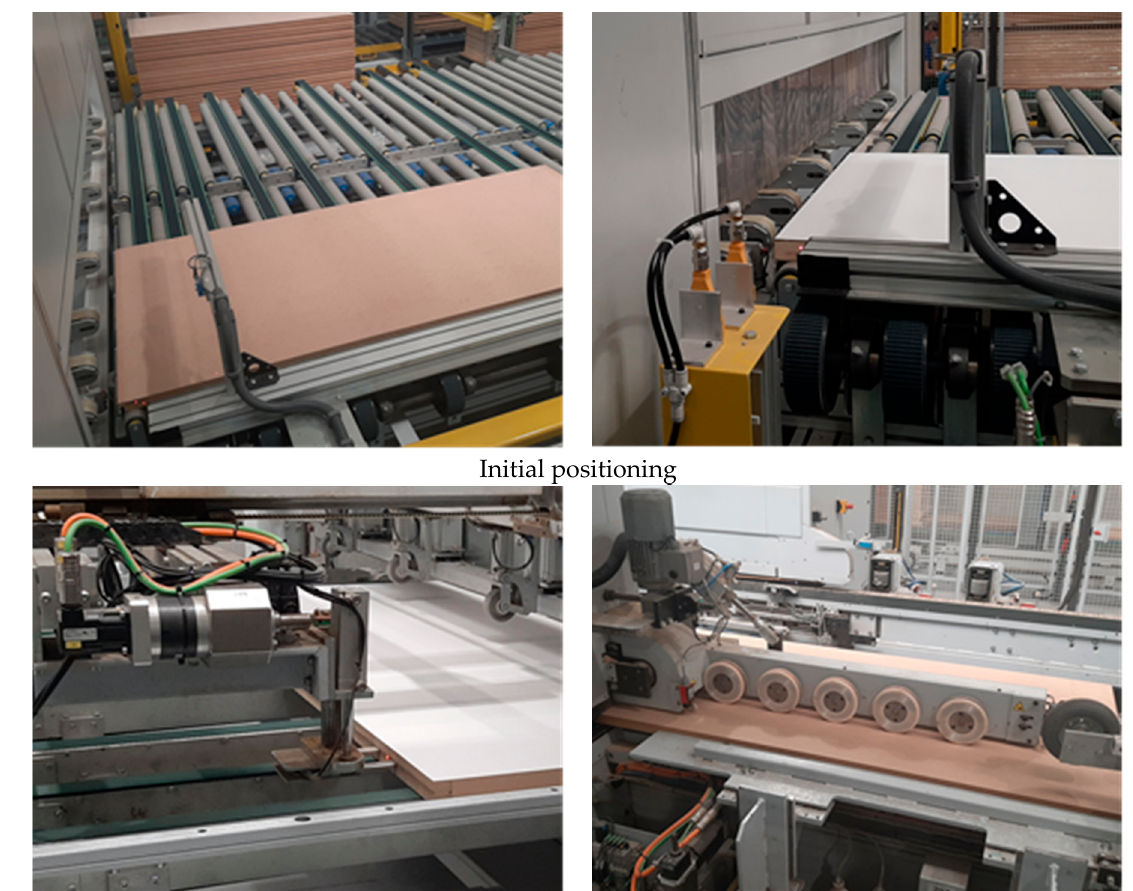
Figure 2. Positioning at edge milling.